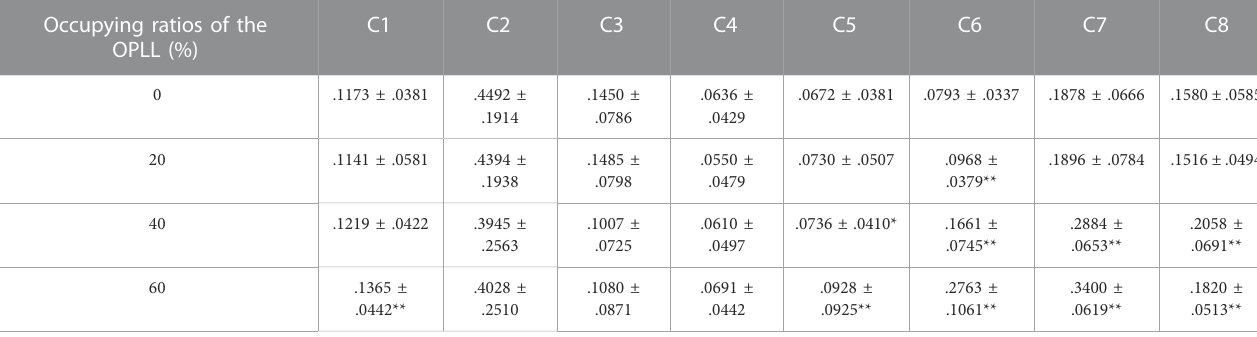
TABLE 2 Von Mises stress of the nerve roots (units:MPa). Occupying ratios of the OPLL